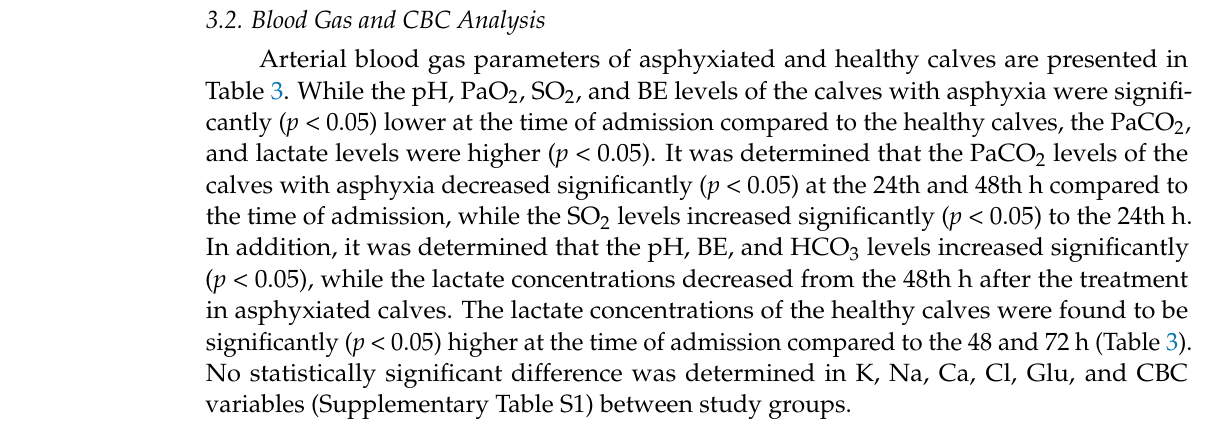
Table 3. Arterial blood gas and chemistry variables of healthy and calves with perinatal